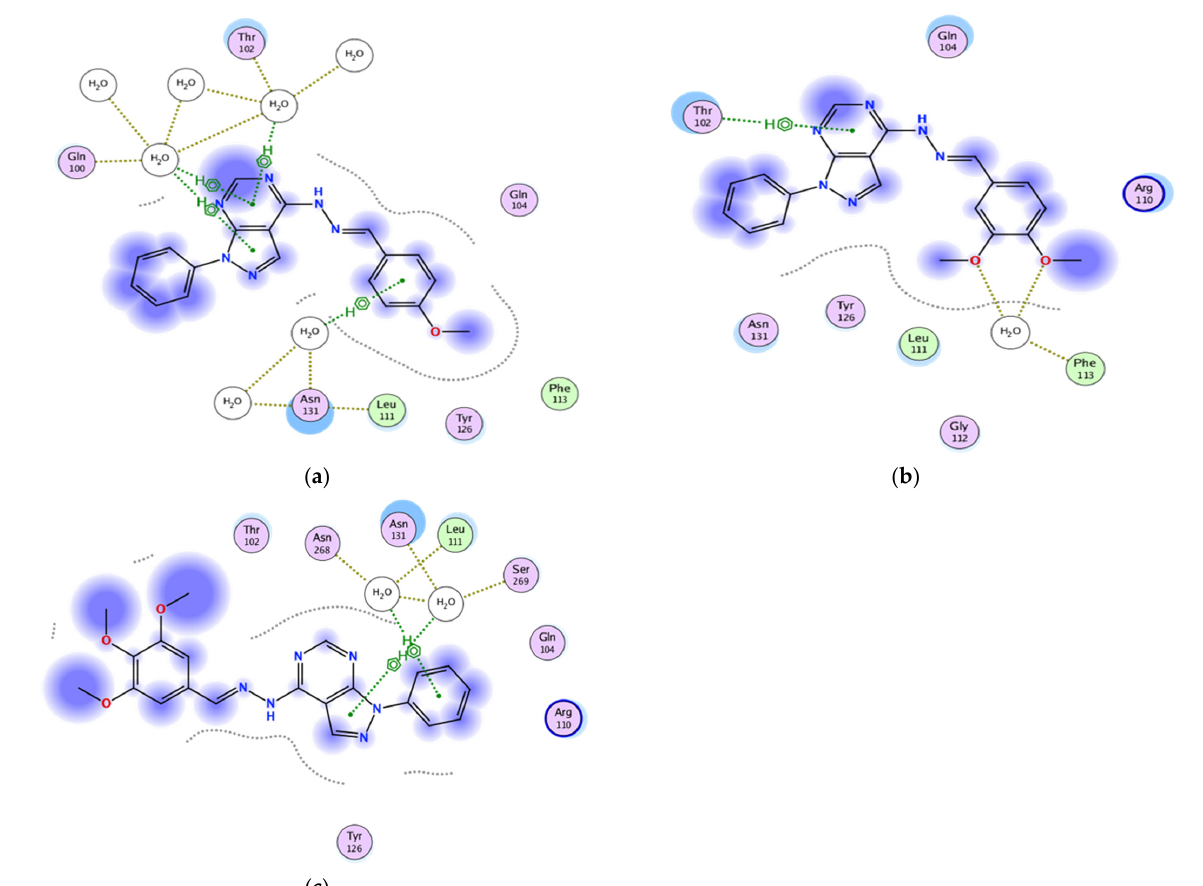
Figure 5. Two-dimensional binding mode of the test compounds ( a ) 6 , ( b ) 5 , and ( c ) 7 in the binding site of P53 protein (PDB ID: 5mct) using MOE software.